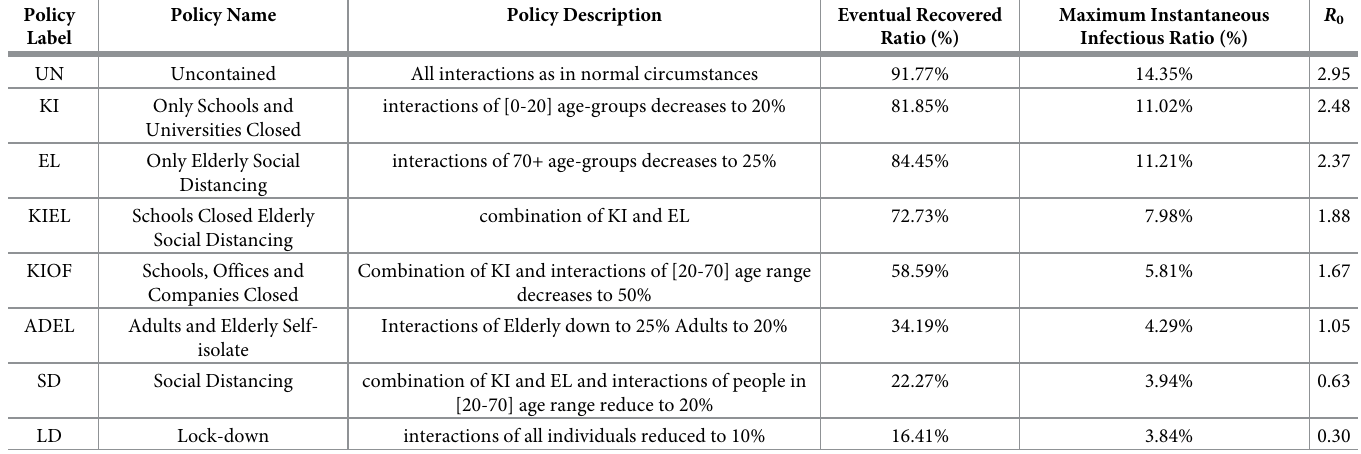
Table 2. Effects of different policies in Germany. Please note that the eventual Recovered ratio is the total ratio of the population which have been infected at any time during the spread of the virus.